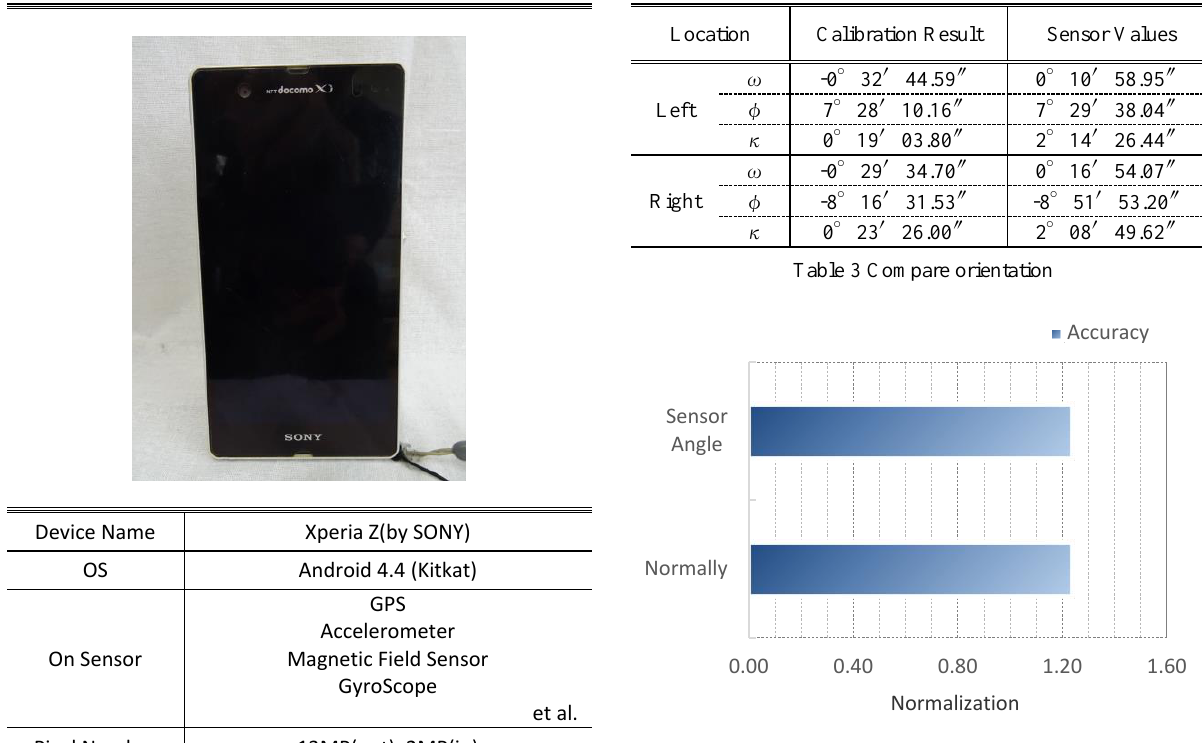
Figure 5. Consumer grade digital camera